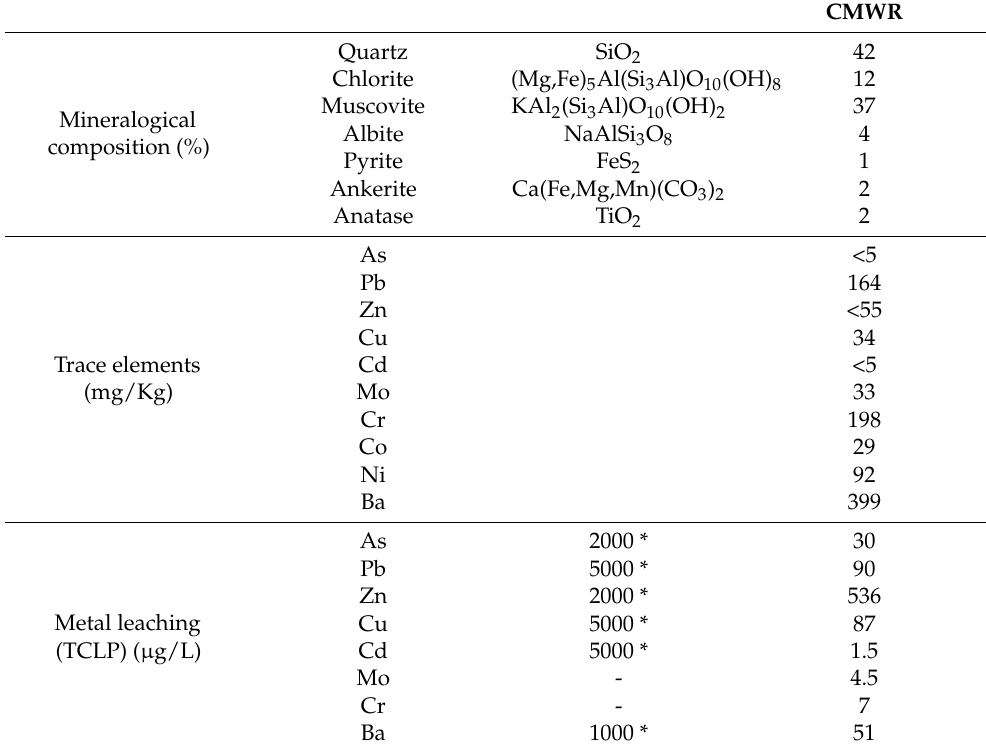
Table 1. Mineralogical, chemical compositions, and metal leaching behavior (TCLP) of